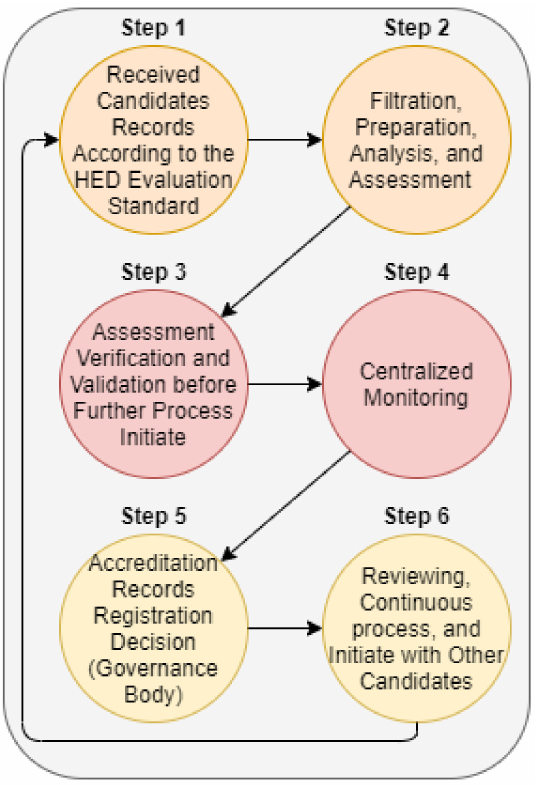
Figure 1. Current process of candidate credential